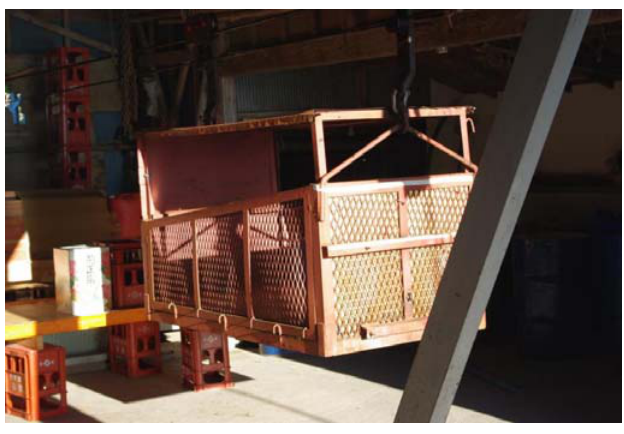
Figure 17. Gondola to carry goods to